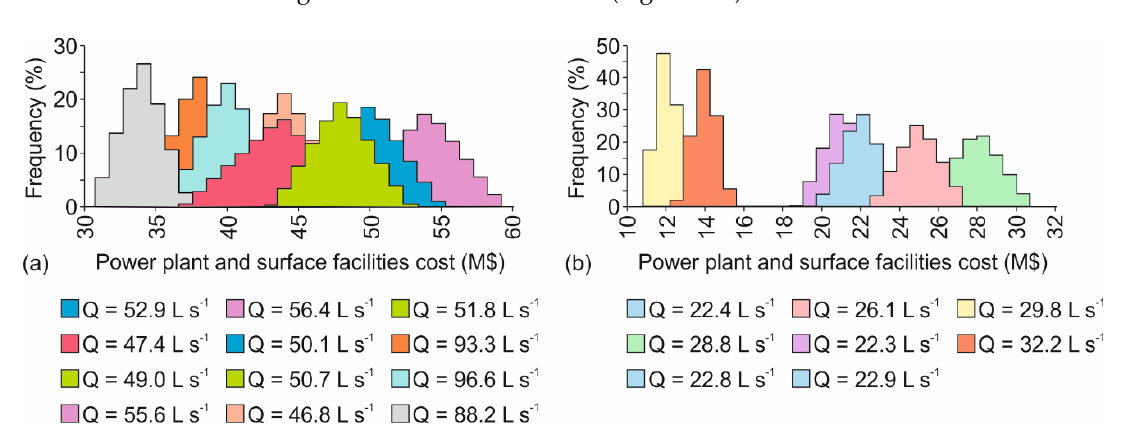
Figure 14. Power plant and other surface facilities cost for each simulated design considering Sanyal et al. [72] costs: ( a ) configuration A (Figure 5); ( b ) configuration B (Figure 5). The cost is in USD. The reader is referred to Tables 4 and 5 for further details on the flow rates.